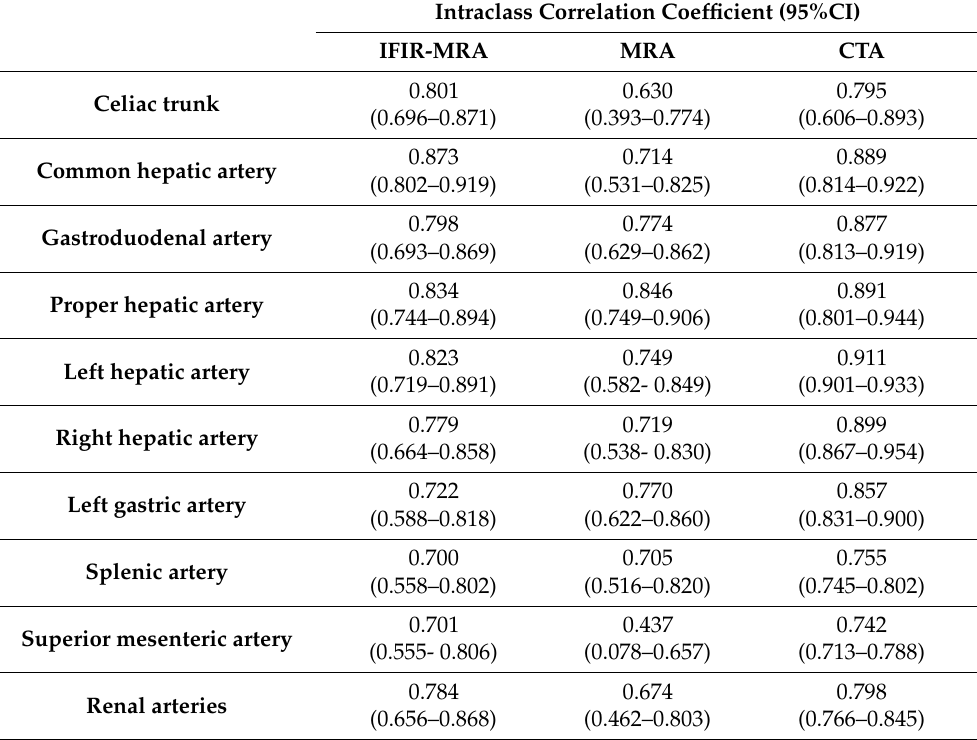
Table 2. Intraclass correlation coefficients between the two readers regarding imaging quality of IFIR-MR, MRA and CTA.